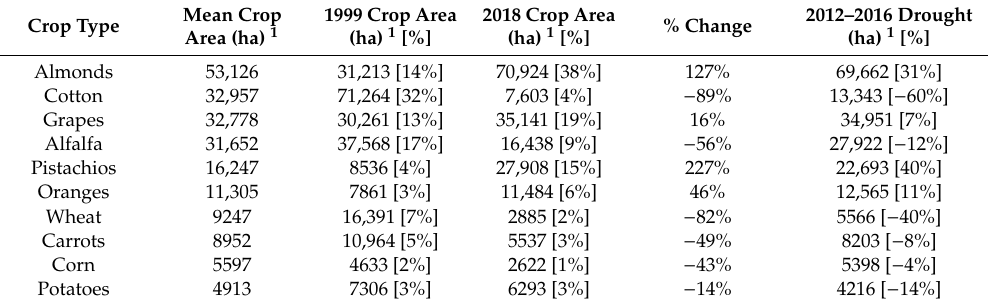
Table 6. Summary statistics of the crop area estimates for the top 10 major crops in Kern County from 1999 to 2018 ordered by the mean including: (1) the mean of the 1999–2018 period, (2) the crop area in 1999 and the percentage of the total crop area, (3) the crop area in 2018 and the percentage of the total crop area, (4) the change in crop area between 1999 and 2018, and (5) the mean crop area during the 2012–2016 California drought and percent deviation from the mean.